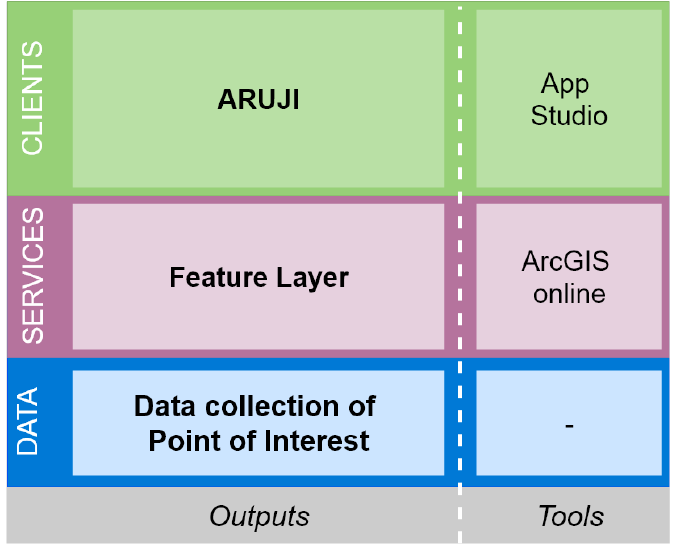
Figure 2. General